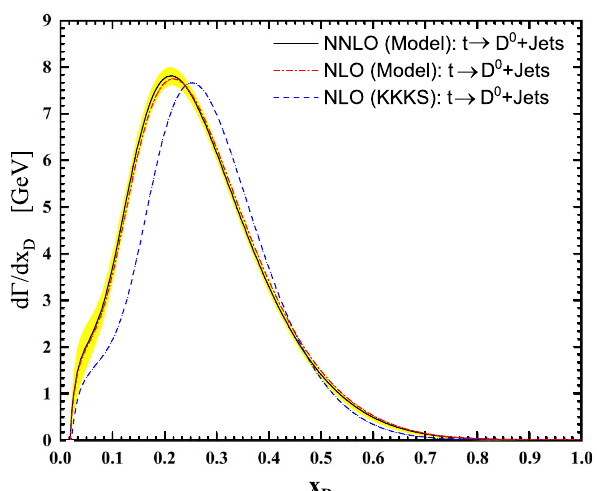
Fig. 5 d (cid:11)( t → D 0 + Jets )/ dx D as a function of x D in NLO (dot- dashed line) and NNLO (solid line) accuracies at μ = m t . Our results are also compared with the NLO one from KKKS08 [17,18]